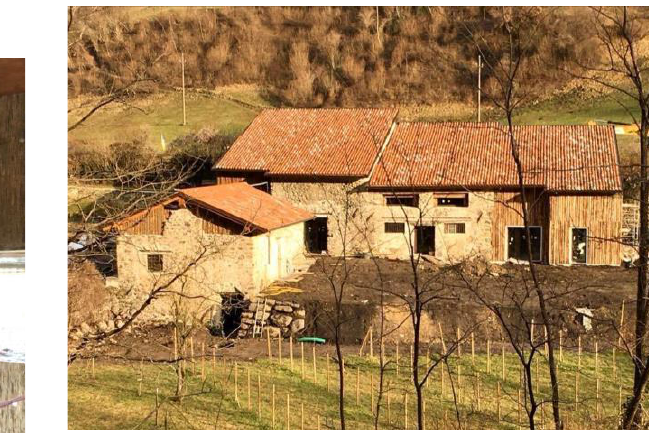
Figure 13. The masonry is covered in wood